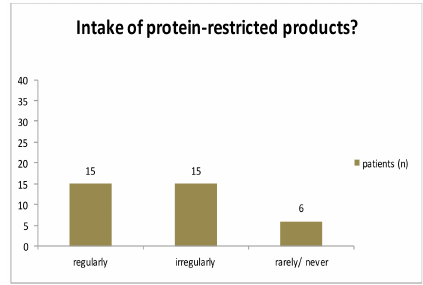
Figure A2. Intake of low-protein food.